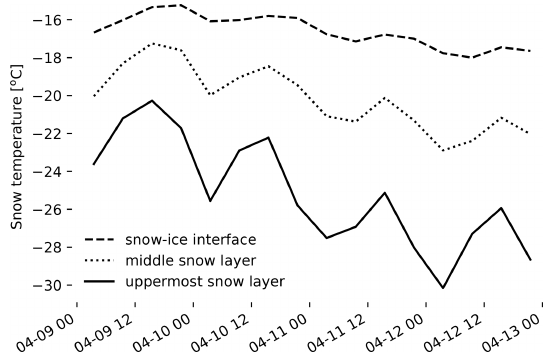
Figure 4. Temperature evolution within the snowpack at the snow– ice interface, 10cm depth and just below the snow surface for the cold period of 9 to 12 April 2020. Temperature is averaged from a subset of four SIMBAs with snow depths of